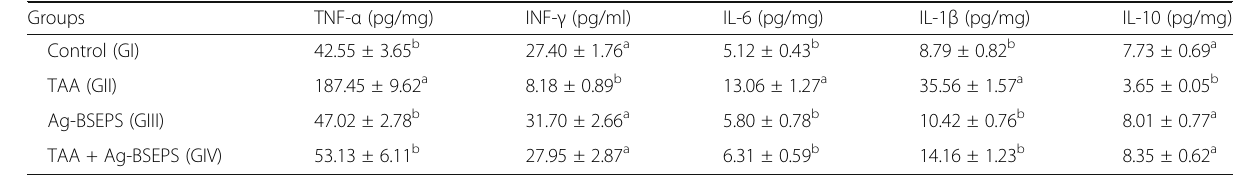
Values are expressed as mean ± SE. Different superscript letters in the same row indicate significant differences at p <